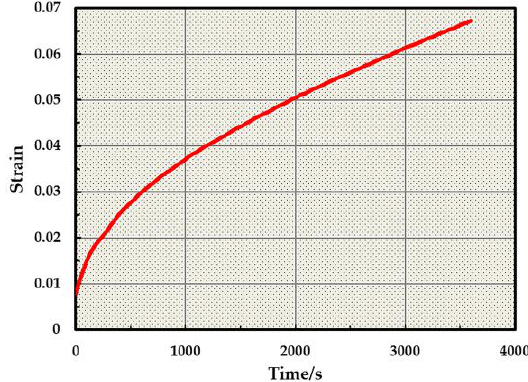
Figure 6. Creep curve of AC-16 asphalt mastic at 60 °C.